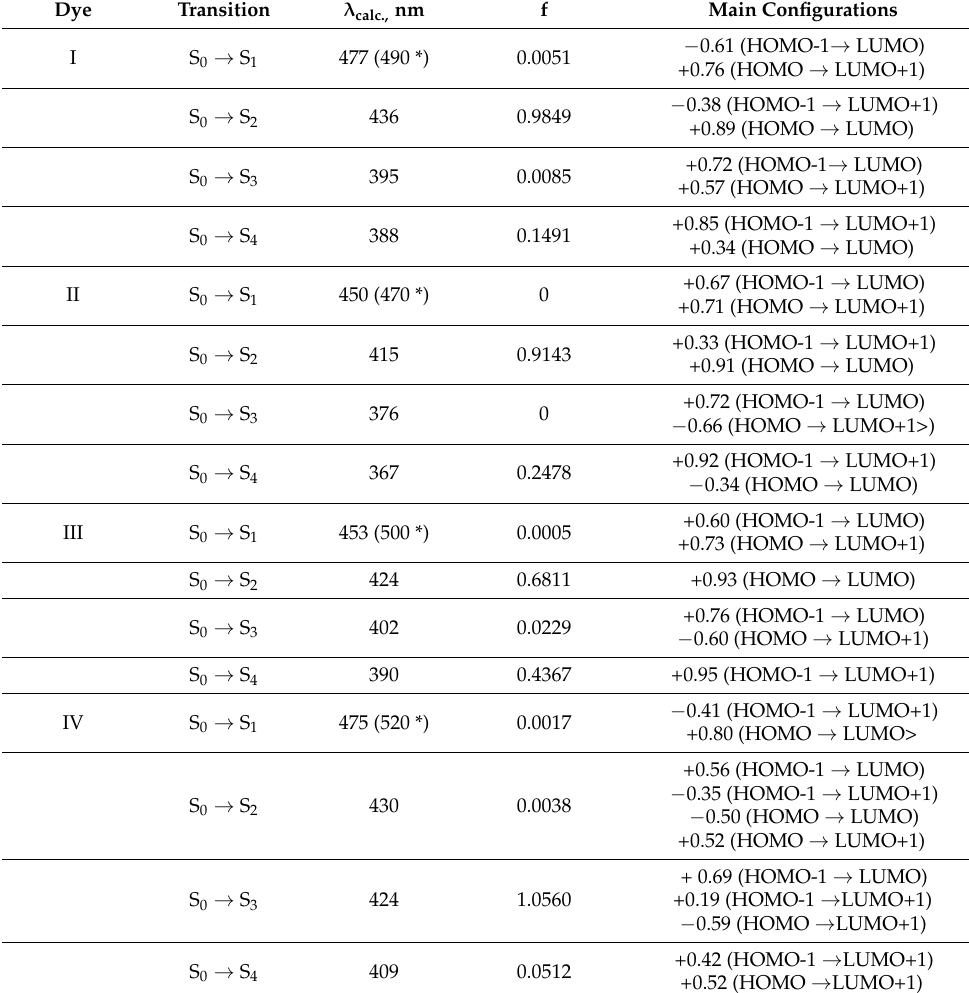
Table 2. Calculated and experimental characteristic parameters of the absorption dimer spectra, where calc.—calculated wavelength of the electronic transition; f—oscillator strength. Dye Transition λ calc., nm